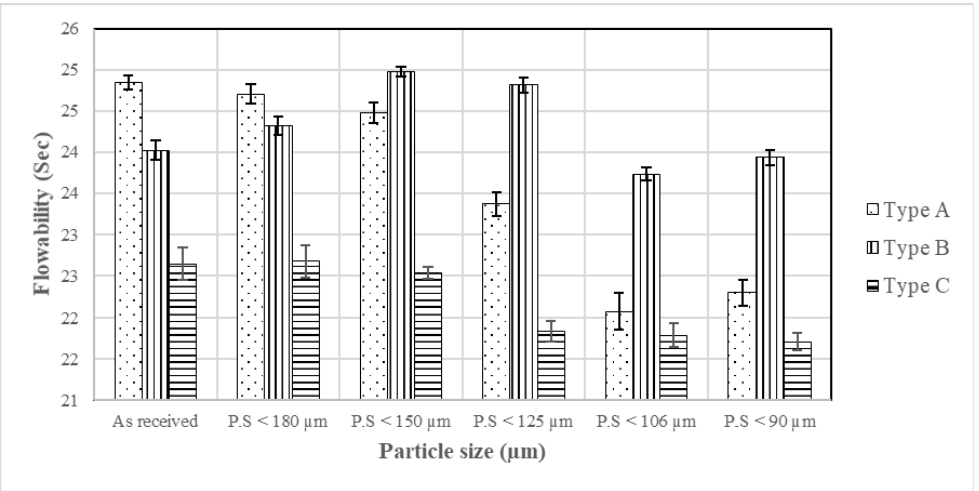
Figure 6. Flowability of pure iron powder, in the as received state, and after removing coarse particles with sizes exceeding 180, 150, 125, 106 and 90 microns respectively.